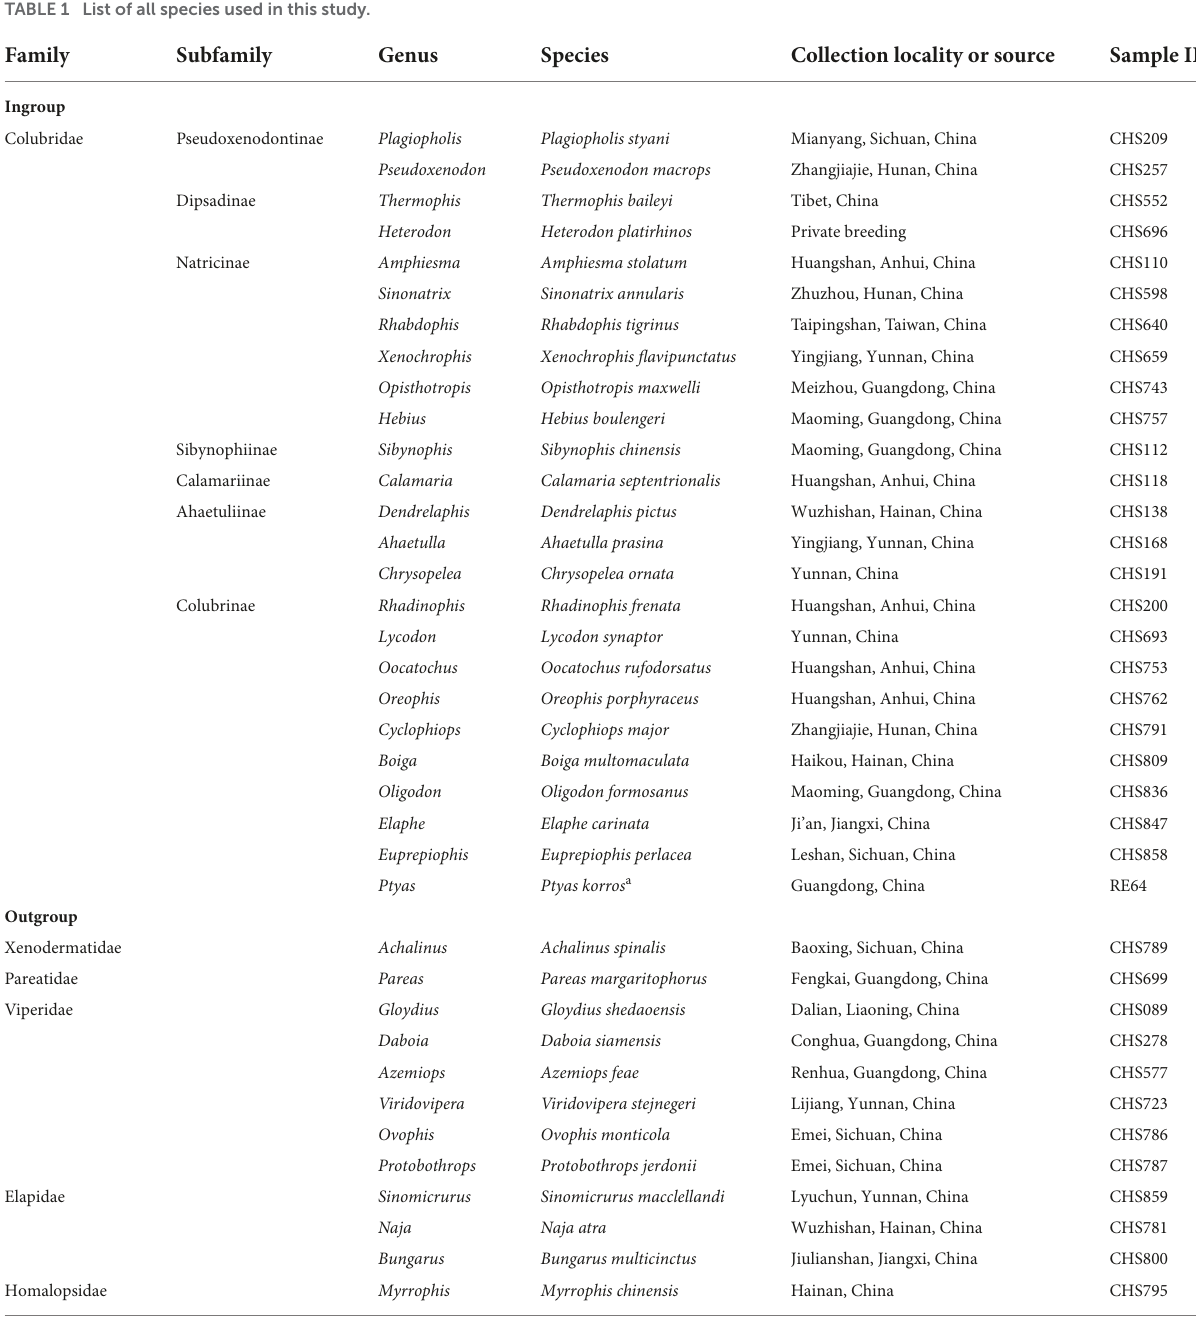
TABLE 1 List of all species used in this